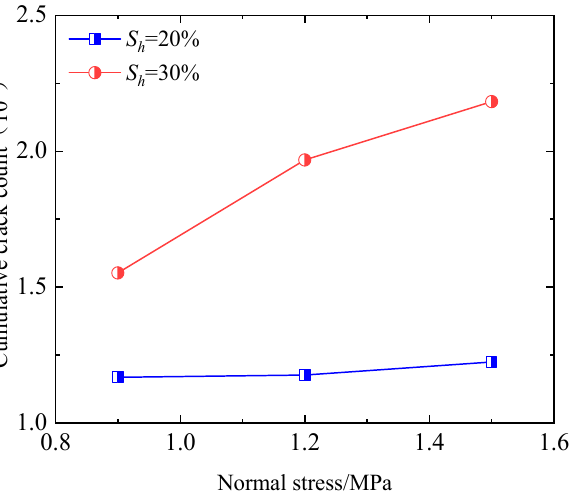
Figure 20. Total cracks accumulated in natural gas hydrate deposits under different conditions.